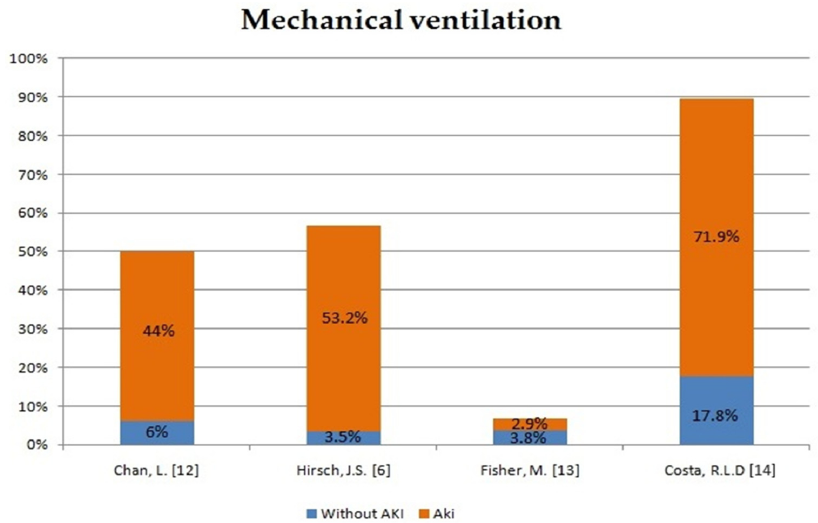
Figure 1. Intensive care unit admission in patients with AKI and no AKI [6,12,13].